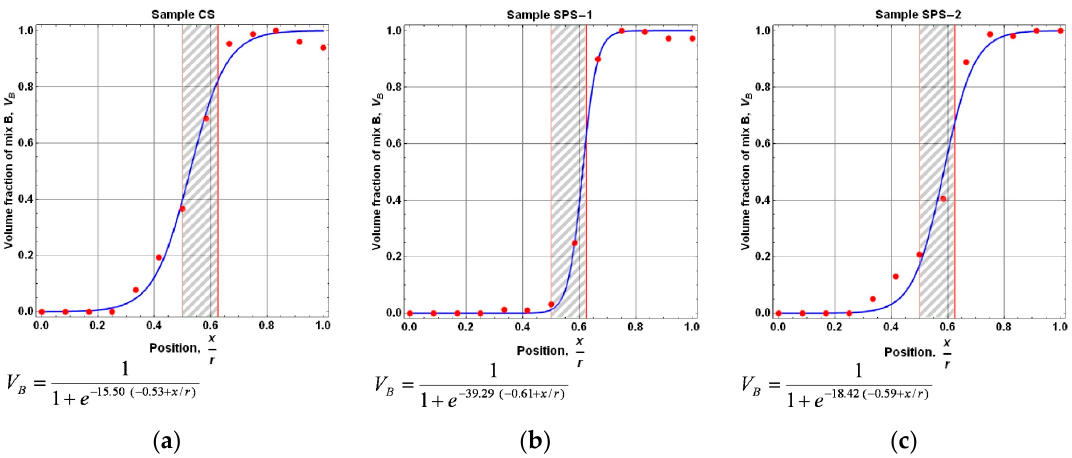
Figure 10. Mathematical description of the volume fraction of Mixture B ( V B ) in the radial direction of products; ( a ) the conventional method (Sample CS), ( b ) SPS, 1120 °C, one min (Sample SPS ‐ 1), ( c ) SPS 1050 °C, 10 min (Sample SPS ‐ 2).